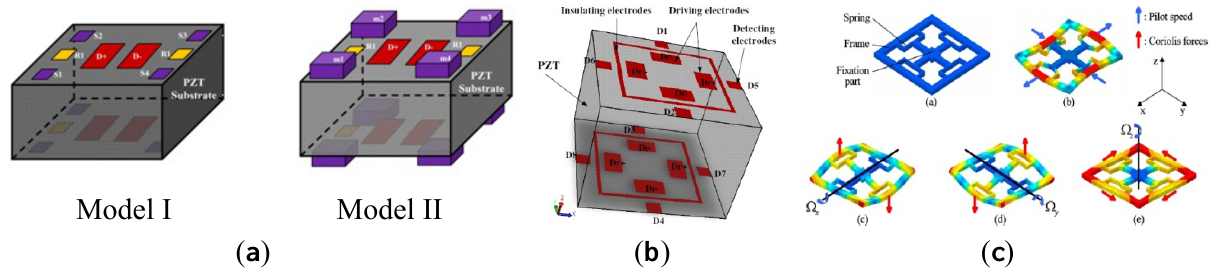
Figure 11. PVGs. ( a ) and ( b ) SJTU PMMG. ( c ) ONERA